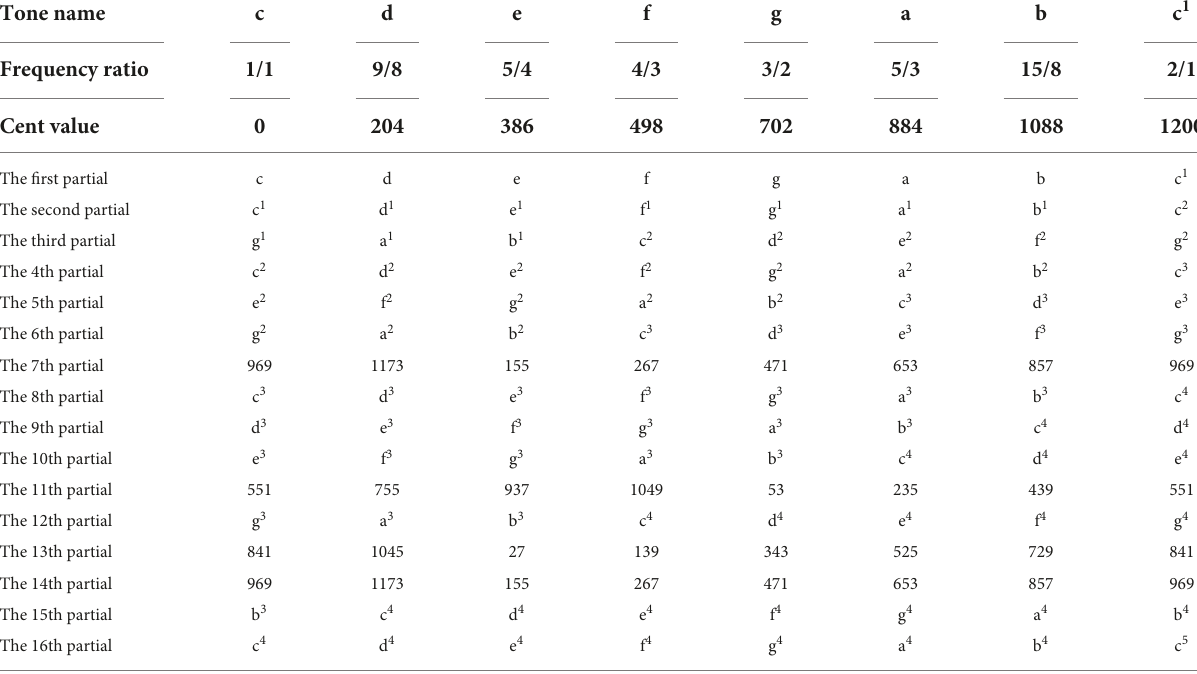
TABLE 3 The partial column of the tones in the pure-tone temperament relative to c (from the first partial to the 16th partial).